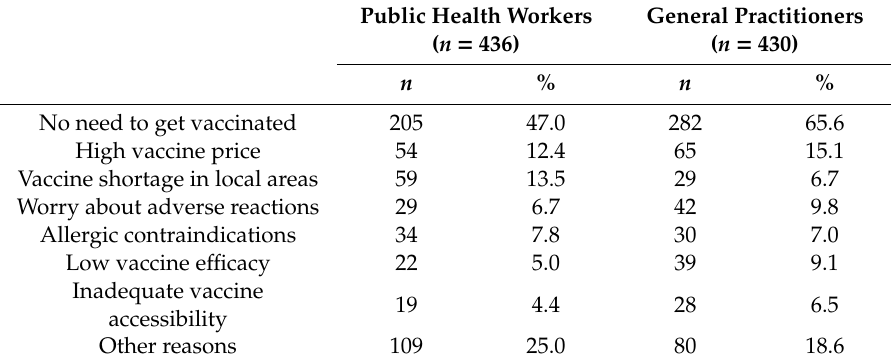
Table 2. Reasons for not being vaccinated among healthcare workers